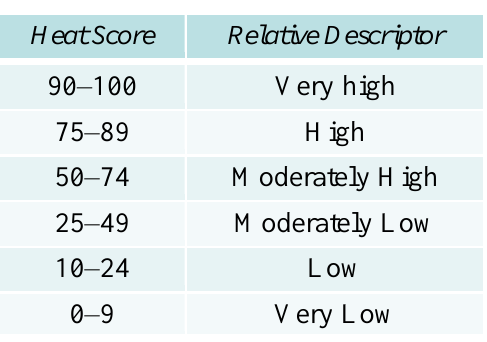
Table 2. HEAT Score ranges and relative